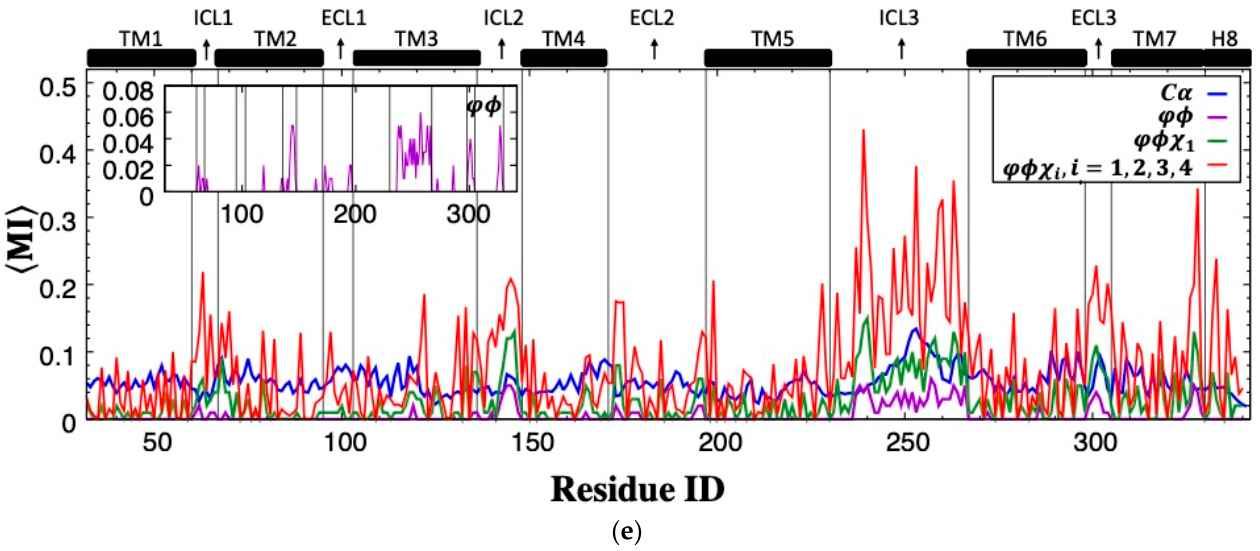
Figure 3. Residue-pair mutual information (MI) plotted with contact map (threshold: 6.0 Å) for ( a ) backbone C α , ( b ) backbone torsion angles ( φ , ψ ) ( c ) backbone torsion and first side-chain torsion angles ( φ , ψ , χ 1 ) , ( d ) backbone torsion and all side-chain torsion angles ( φ , ψ , χ i , i = 1,2,3,4 ) . ( e ) Mean mutual information per residue averaged over the rest of the receptor. (Green dots: 0.25 < MI ≤ 0.5; red dots: MI >